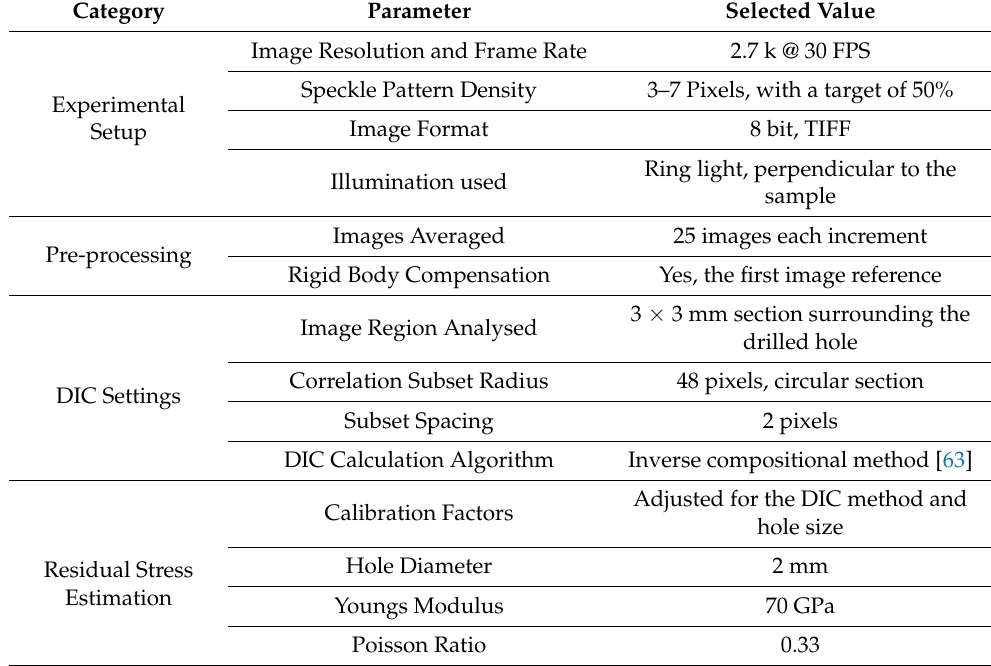
Table 5. Key parameters used in the